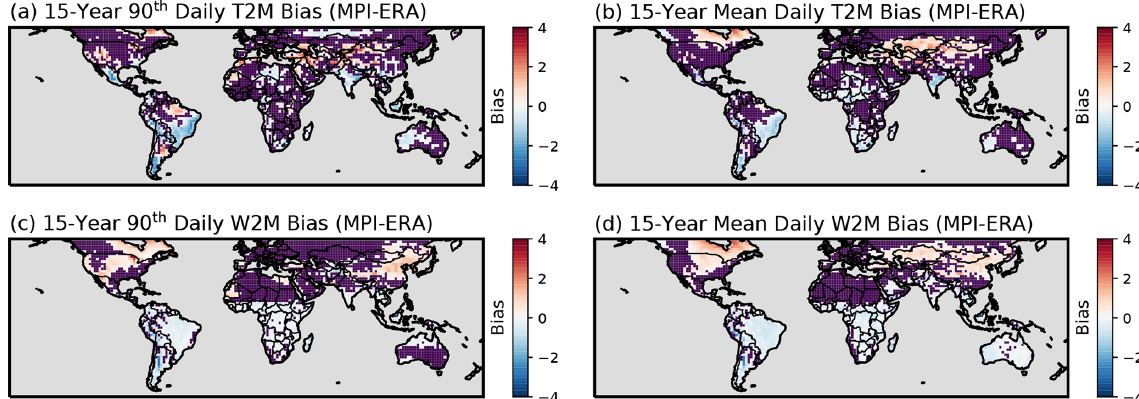
Figure 1. Difference of 1% CO 2 runs compared with ERA-Interim in the same level of global warming (0.87 ◦ C). The grid points where ERA-Interim falls within the ensemble spread of 1% runs are masked with gray, while other grid points show the difference between the nearest ensemble member and ERA-Interim for the (a) 90th percentile of the 15-year daily average t2m, (b) the mean of 15-year daily average t2m, the (c) 90th percentile of 15-year daily average w2m, and (d) the mean of 15-year daily average